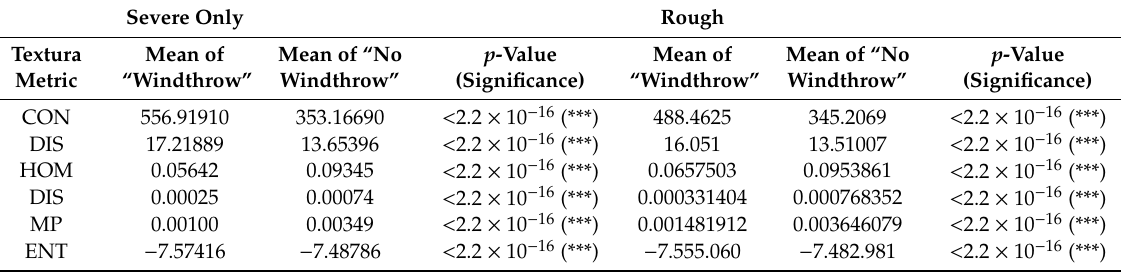
Table 5. Mean values and p -values for the Welsh t -test for the calculated texture metrics in “severe only” and “rough”